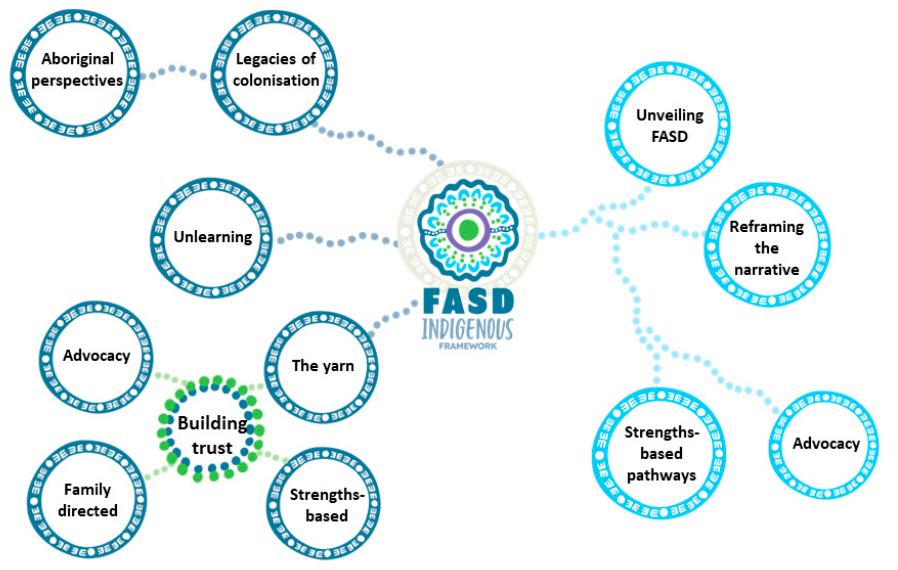
Figure 1. The current Australian FASD Indigenous Framework summarises the shifts non-Aboriginal clinicians and Aboriginal peoples need to make in their respective knowing, being and doing to facilitate access to FASD knowledge, services and support among Aboriginal peoples. The dark blue circles represent the shifts that non-Aboriginal clinicians need to make in their knowing, being and doing to deliver culturally responsive, healing-informed and trauma-aware FASD knowledge, services and support to Aboriginal peoples. The light blue circles represent the shifts that Aboriginal communities need to make in their knowing, being and doing to access FASD knowledge, services and support. The FASD Indigenous Framework visuals were designed by Worimi communication specialist Isaac Simons and non-Aboriginal graphic artist Daniel Richards. This community-informed design embodies the seamless flow of relationships and knowledge in Aboriginal and Torres Strait Islander communities and honours the strength of layered reciprocity and support that exists to nurture new life. The colours reflect the healing qualities of water and the vibrant and flourishing colours of fresh vegetation. The design captures the continuity of culture and encompasses the whole support process to highlight that everything is supported through connections with culture.